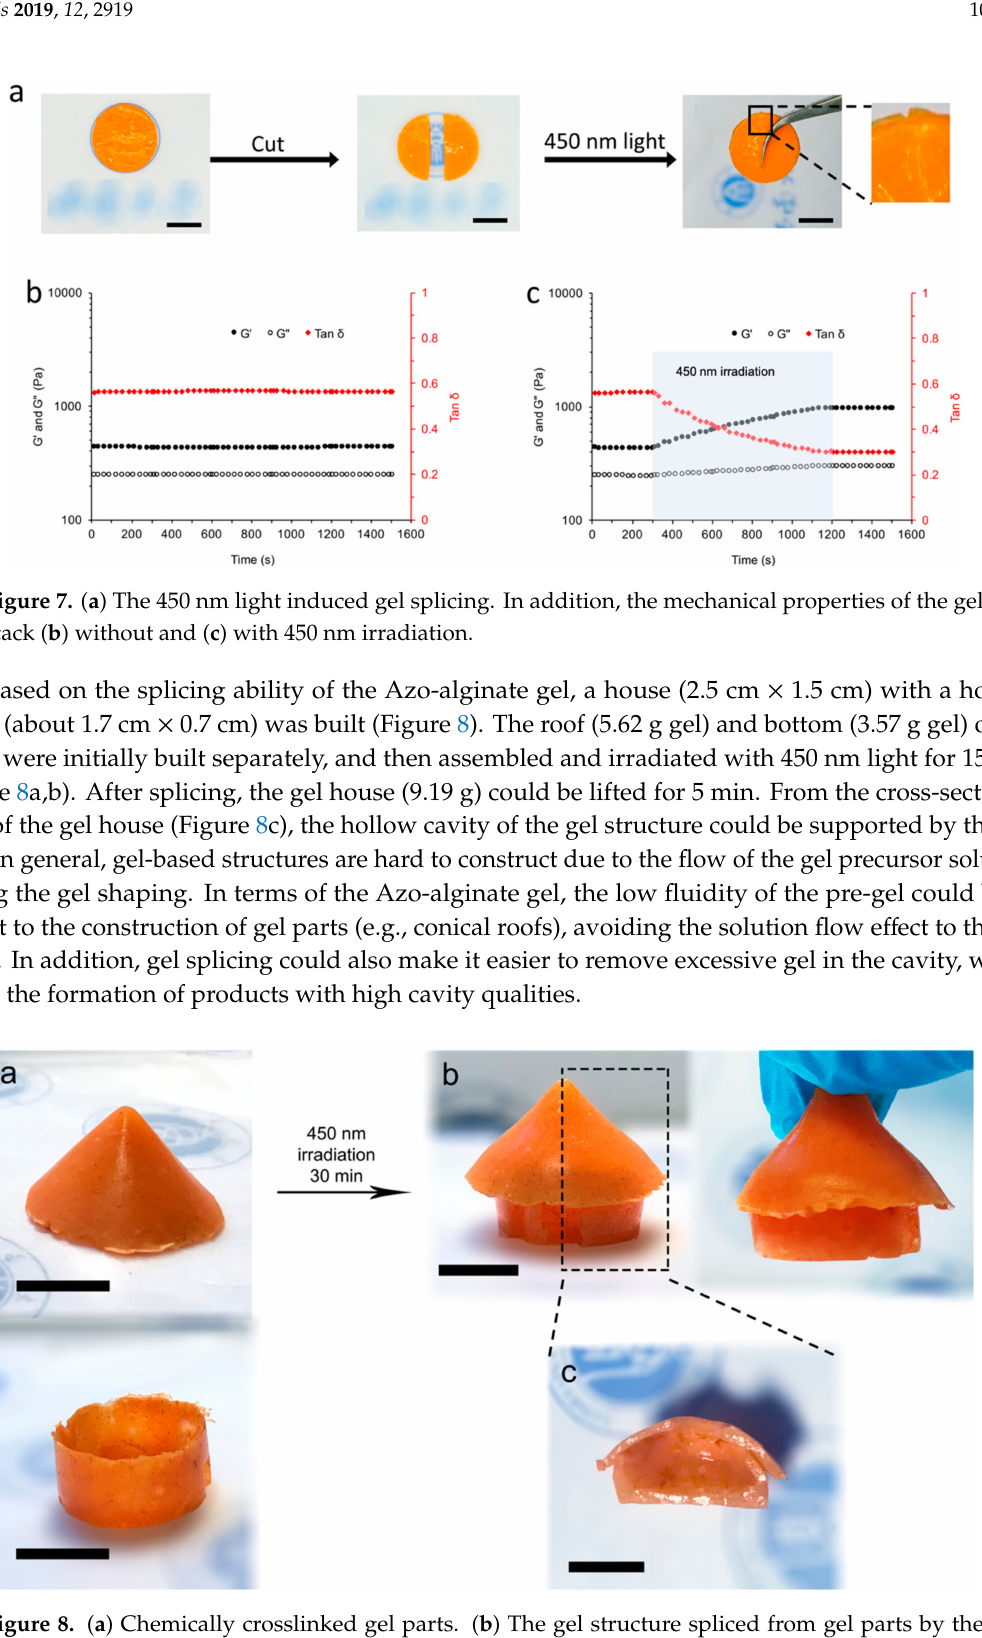
Figure 8. ( a ) Chemically crosslinked gel parts. ( b ) The gel structure spliced from gel parts by the 450 nm light irradiation. ( c ) Longitudinal cut surface of the gel structure, with hollow cavity. (Scale bar = 1